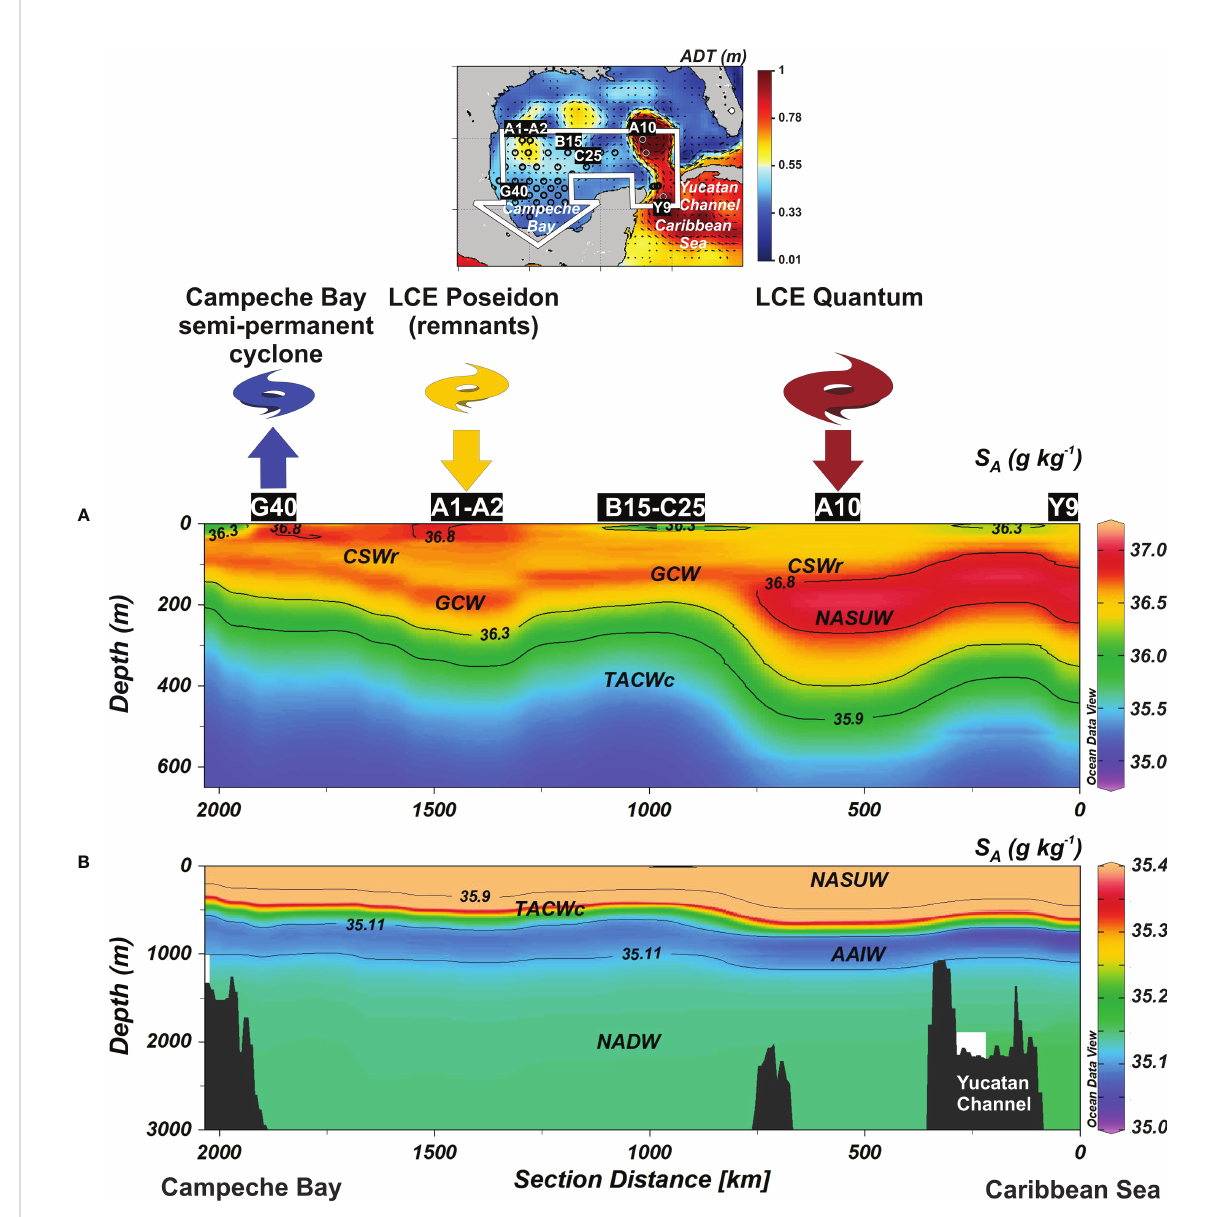
FIGURE 3 Sectional distribution of absolute salinity (S A ) during the XIXIMI-6 cruise along a transect that begins in the Caribbean Sea and ends in the Gulf of Mexico in the Campeche Bay area: (A) from 0 to 600 m depth and (B) from 0 to 3500 m depth. The locations of the sampling stations marked in panel (A) are shown in the map above. The big white arrow shown on the map indicates the direction and extent of the transect. To improve the visual identi fi cation of water masses, the range of S A values represented by the color scale is different for (A, B) . The black solid contours indicate the isohaline boundaries of water masses based on the classi fi cation proposed by Portela et al. (2018). ADT, absolute dynamic topography; LCE, Loop Current eddy; CSWr, Caribbean Surface Water remnant; GCW, Gulf Common Water; NASUW, North Atlantic Subtropical Underwater; TACWc, Tropical Atlantic Central Water core; AAIW, Antarctic Intermediate Water; and NADW, North Atlantic Deep